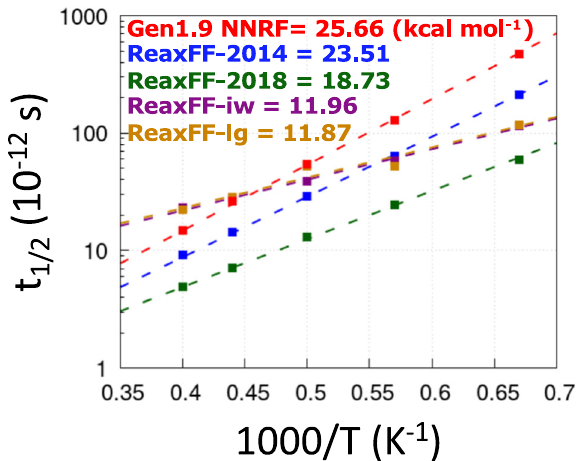
Fig. 10 The overall kinetic activation barriers of RDX system. Comparison of global activation barrier (in kcal mol − 1 ) between Gen1.9 NNRF and the four parameterizations of ReaxFF (shown in top left of the fi gure). ReaxFF-lg and ReaxFF-iw have much lower barriers compared to the Gen1.9 NNRF, ReaxFF-2014, and ReaxFF- 2018 which are very